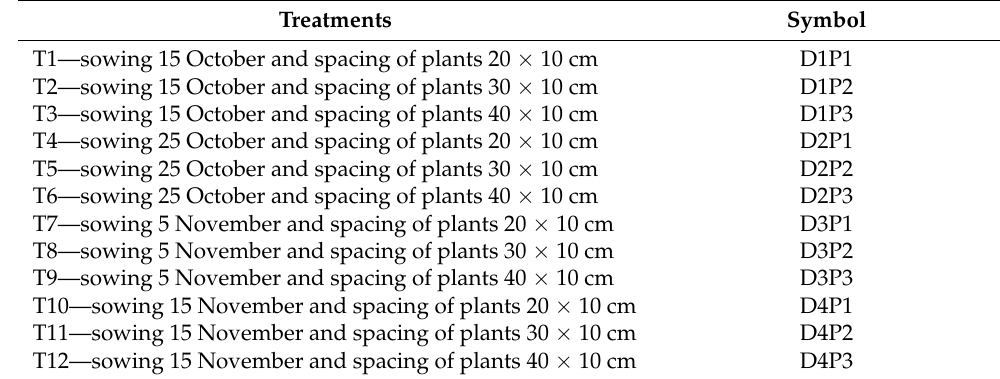
Table 1. Treatment details with sowing date and spacing of plants of chamomile ( Matricaria chamomilla L.). Treatments